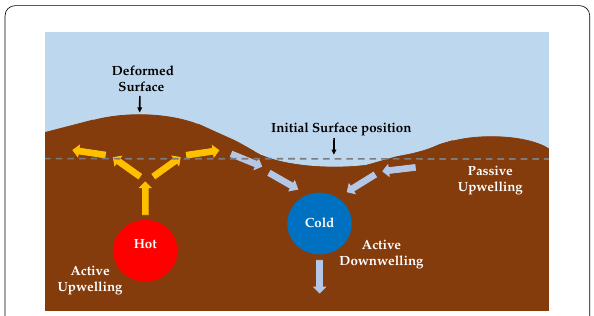
Fig. 10 Schematic of some of the processes associated with dynamic topography adapted from Austermann and Forte (2019). Since sea level is representative of geoid position relative to surface elevation, it is influenced by long-term mantle flow and relative motion between the mantle and the overlying